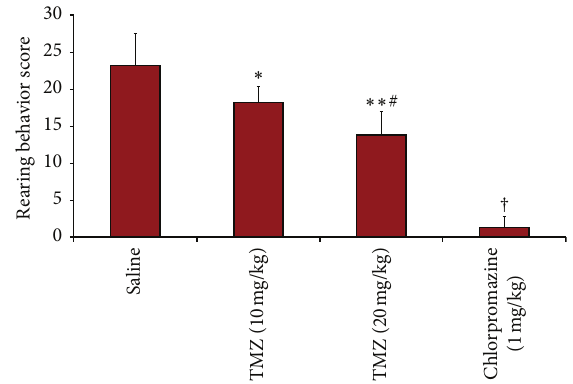
Figure 1: Rearing behavior scores. Data are expressed as mean ± SEM. Statistical analysis was performed by one-way analysis of variance (ANOVA) and Bonferroni’s post hoc test. ∗ different from saline , 𝑃 = 0.037 , ∗∗ different from saline , 𝑃 = 0.000 , # different from TMZ (10mg/kg), 𝑃 = 0.029 , † different from other groups, 𝑃 = 0.000 .